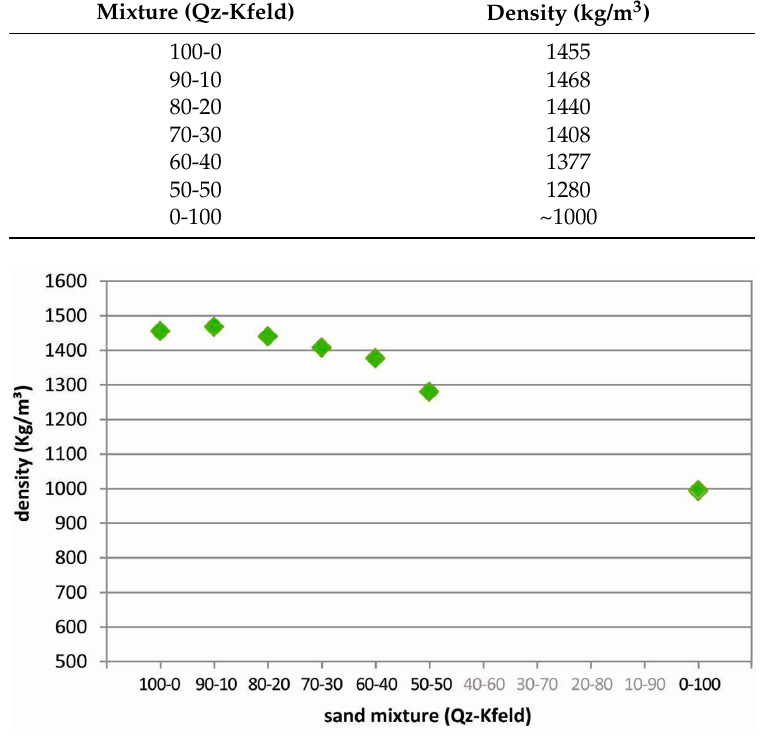
Figure 9. Variation of bulk density as a function of the granular mixture composition.